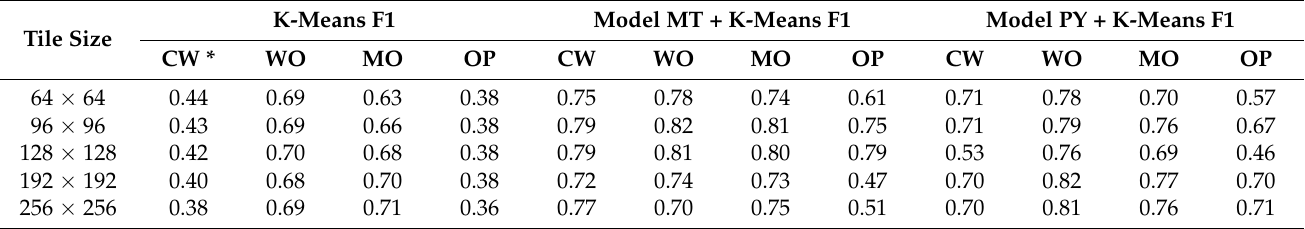
Table 8. F1 scores of the unsupervised learning methods for each unit in Top